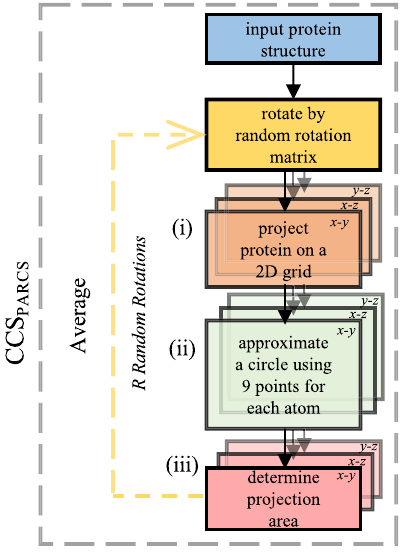
Fig. 6 | Overview of collision cross section (CCS) calculation using rough cir- cular shapes (PARCS) algorithm. a Schematic of the PARCS algorithm to predict CCS from structure. (i) Three projections are obtained from each rotation. (ii) For each atom in each projection the 2 dimensional (2D) grid is fi lled according to a 9-point circle approximation. (iii) The projection area is determined from the number of fi lled grid cells. b Illustration of a (i) 2D projection of a single random